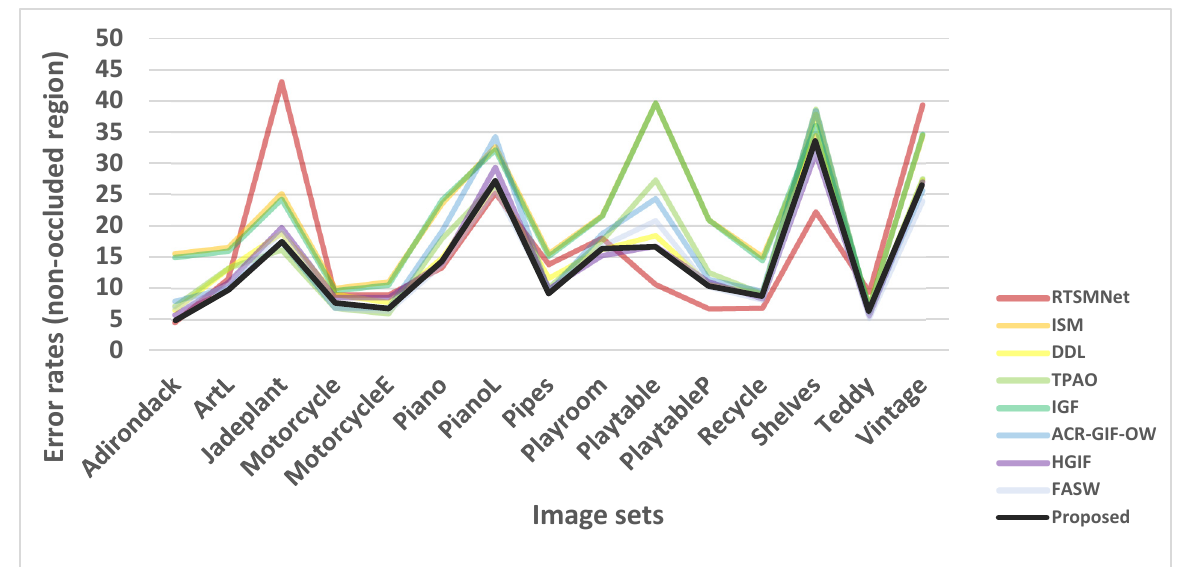
Figure 6. Comparison of the error rates in the non-occluded region. This diagram is a graphical representation of Table 2.